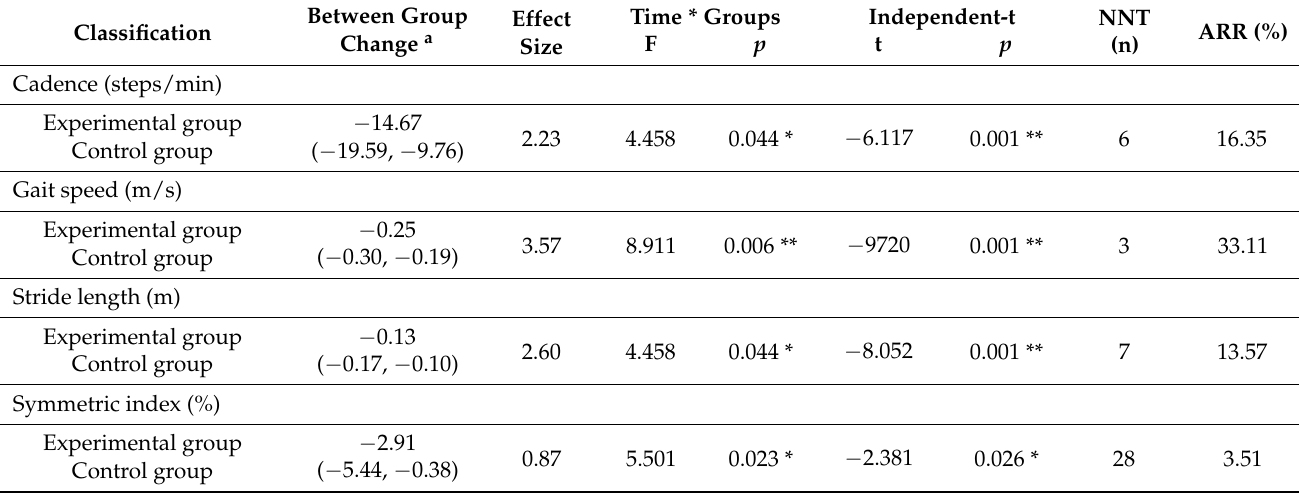
Table 4. Changes in gait performance between intervention on two intervention groups.